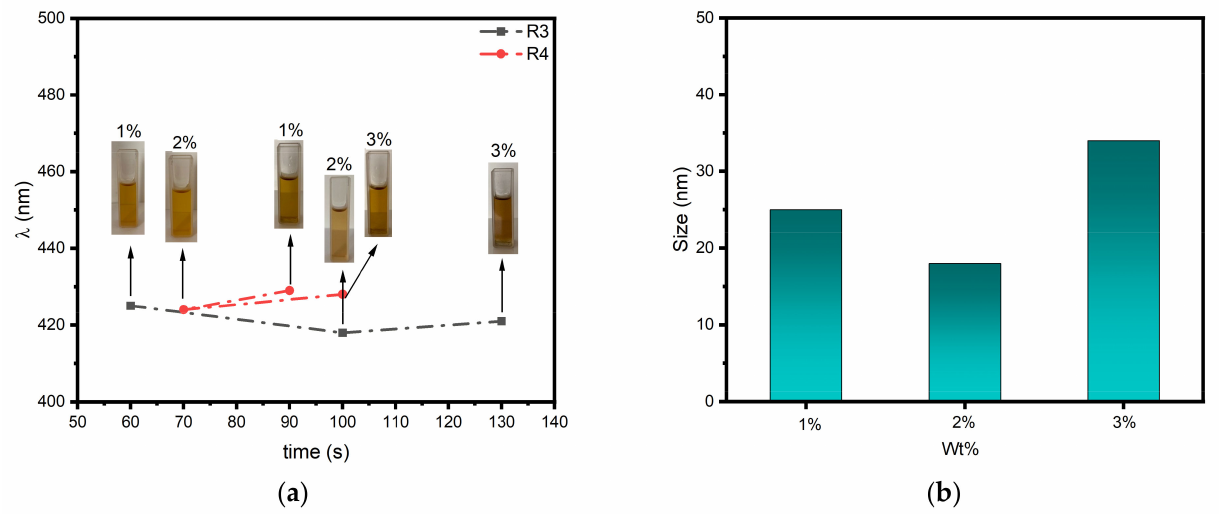
Figure 6. The salts AgNO 3 are prepared at different ( w / w ) (1%, 2%, 3%) ( a ) and comparison between different sizes of silver nanoparticles ( b